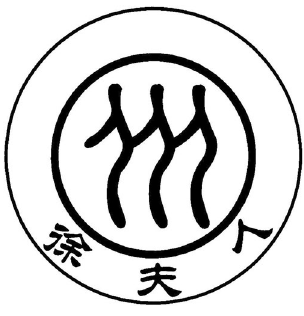
Fig. 6 “ Xu Fu Ren ” trademark of Chun Hui Da Di Company. Application/